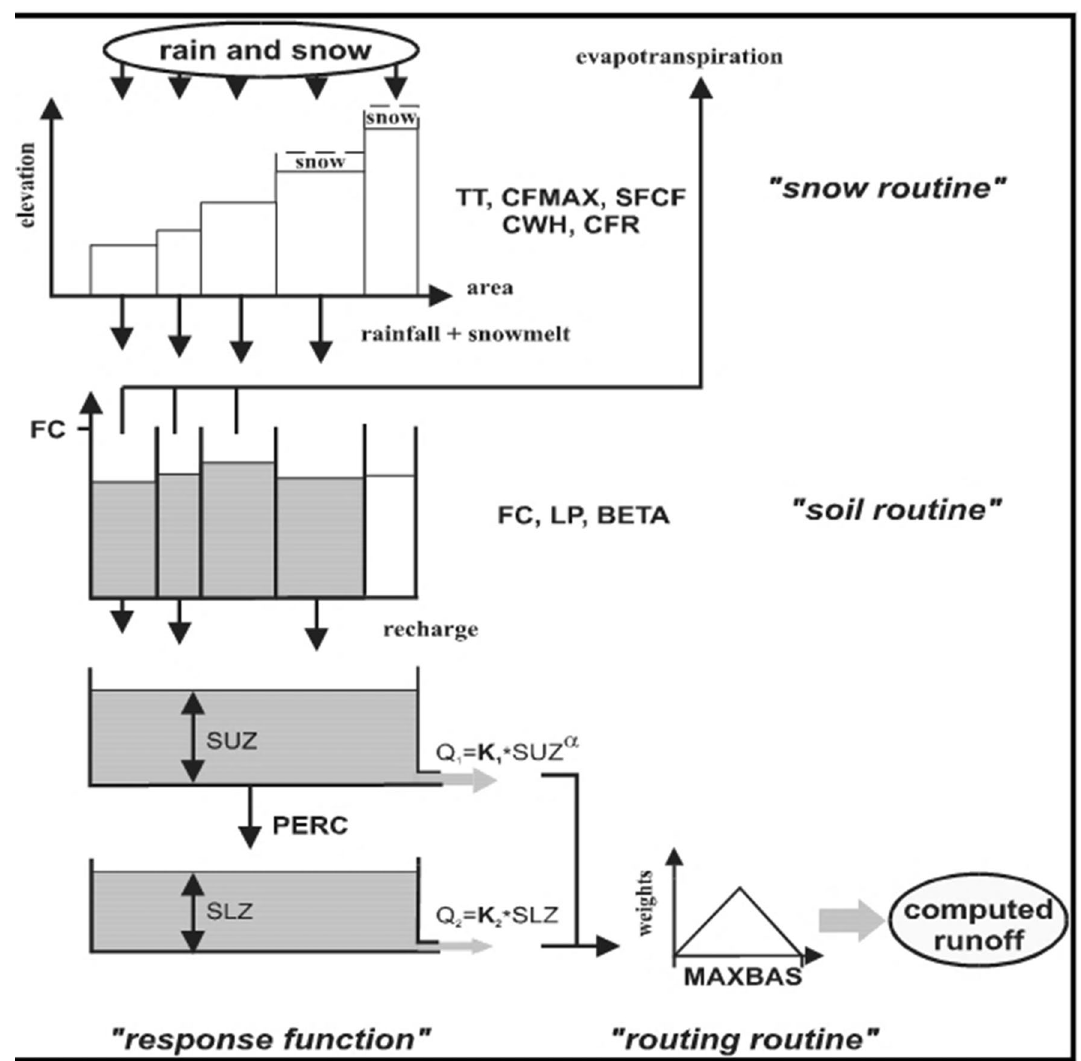
Fig. 2 Structure of the HBV